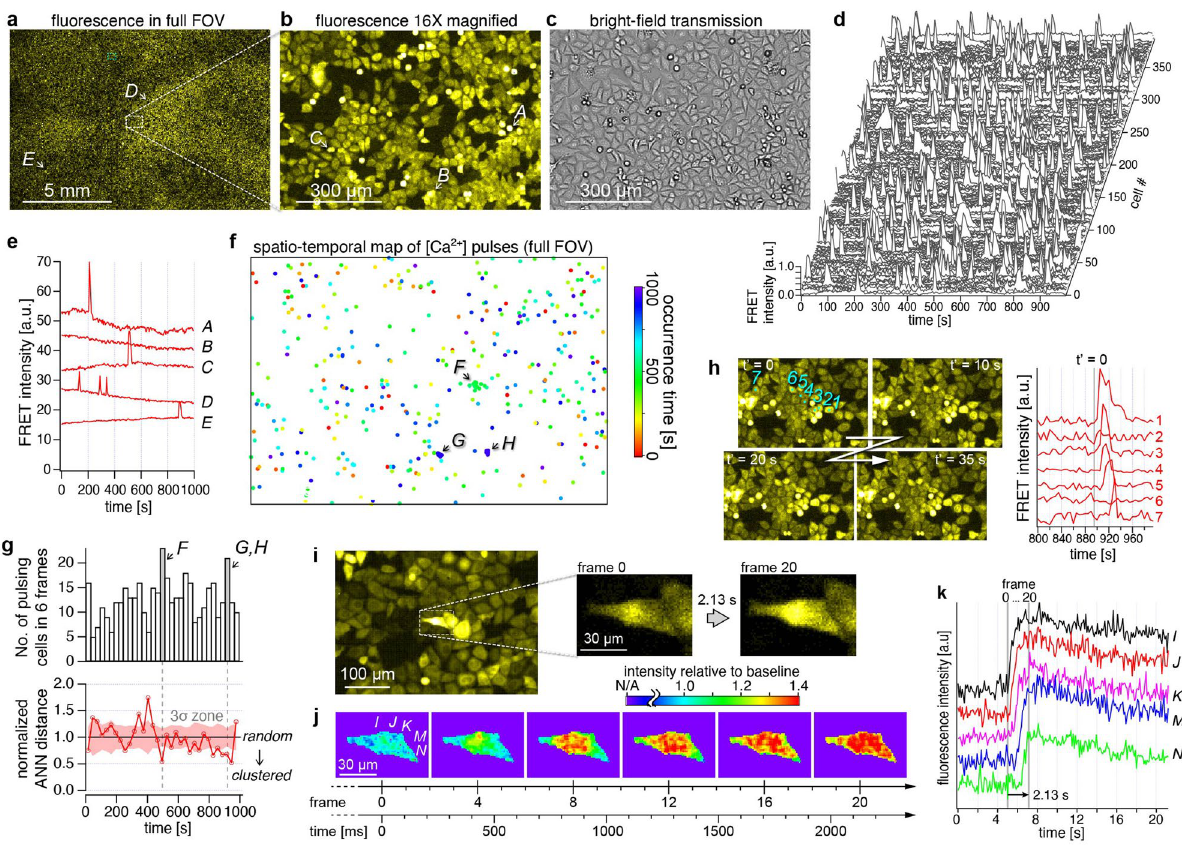
Figure 4. Rare event detection by calcium ion imaging in HeLa cells. ( a , b ) Fluorescence intensity image of the FRET channel in ( a ) the full FOV, and ( b ) a 16 × magnified image of the dashed square region indicated in ( a ). ( c ) Bright-field image of the region described in ( b ). ( d ) Temporal profiles of FRET channel intensity of 394 detected cells exhibiting spontaneous calcium pulse. ( e ) Temporal profiles of FRET channel intensity of five cells indicated with alphabets A - E in ( a ) and ( b ), including those exhibiting 1 and 3 peaks of spontaneous [Ca 2+ ] pulses ( A , C-E ) and one with no peak ( B ). Images were acquired at 5-s intervals. ( f ) A plot of all cell positions detected in the 1000-s measurement time. The occurrence time is indicated with red-green-blue color. ( g ) Time variation of the number of pulsing cells in the full FOV (top) and normalized average nearest neighbor (ANN) distance (bottom). The time bin width of the histogram is 6 frames (= 30 s). The light-red shade represents three times the width of the standard deviation. ( h ) Four image frames showing the [Ca 2+ ] propagation at the location g , along with a part of temporal profiles of the seven cells numbered 1–7. ( i , j ) Intracellular propagation of [Ca 2+ ] observed at 9.4 fps. ( i ) A raw image in the region indicated with a dashed light-blue square in ( a ), with the closeups just before and after the [Ca 2+ ] increase. ( j ) Emergence and propagation of [Ca 2+ ] within a cell displayed with an intensity relative to the baselines of temporal profiles at each pixel. ( k ) Temporal profiles with offsets at five positions indicated with I - N in the left panel of ( j ). Power densities for the imaging with 5-s intervals ( d – h ) and with 9.4 fps ( i – k ) were 25.8 mW/cm 2 and 40.8 mW/cm 2 , To visualize and quantify [cAMP], we specifically designed and constructed D. discoideum cells expressing a ratiometric fluorescent indicator, a fusion protein Red-FL2 of Flamindo2 34 and a monomeric red fluorescent protein (mRFP) 35 , which are sensitive and insensitive to [cAMP], respectively. Dual-color mapping allows for the visualization of low-[cAMP] cells in yellow color and high-[cAMP] cells in red color. We cultured clonal population of the above cell line, and replaced the culture medium by a development buffer at a time point ( t = 0) to set a starvation condition to trigger the pattern formation. Figure 5a shows the time evolution of the macro- scale pattern of cAMP signaling at five time points in more than 15 h of the measurement period. The number of cells observed in the FOV was approximately 2.4 × 10 5 at the beginning of the measurement ( t ~ 0). We were able to observe the transition of the macroscale pattern starting from the non-wave state (Fig. 5a, left and 2nd- left) followed by a spiral wave (center) and a circular wave (2nd-right). Finally, the cells migrated toward the centers of the circles to form multicellular aggregates (right). In all phases of the macroscale pattern formation, the cAMP of individual cells as well as their movement were observed at sub-cell resolutions (Fig. 5b–d). The spatial resolution (< 2.5 µm) and image acquisition frequency (every 30 s) were high enough to recognize single cell motion and morphology (Fig. S7). An overall video of the full FOV and magnified views can be found in the supplementary materials (Video 4).